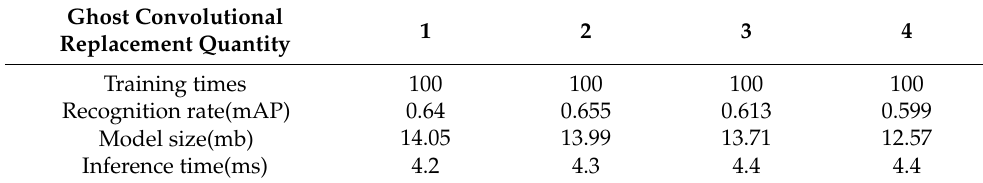
Table 3. Ghost module experimental parameter table.